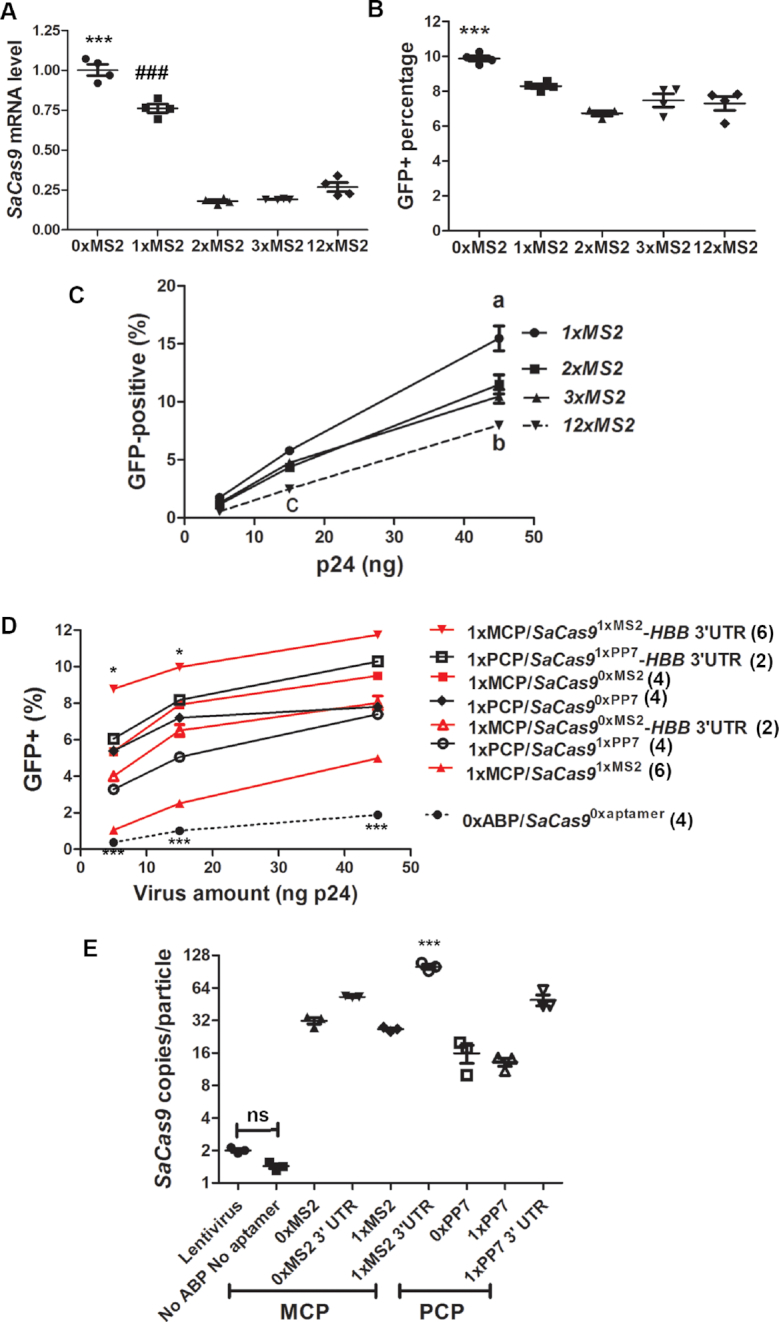
Gene editing activities of various LVLPs. (A) Effects of MS2 aptamers on SaCas9 mRNA level. Plasmid DNA expressing SaCas9nxMS2 (250 ng) was co-transfected into GFP-reporter cells grown in 24-well plates with plasmid DNA expressing HBB sgRNA1 (250 ng). SaCas9 mRNA level was compared by RT-qPCR with HBB sgRNA1 as a control. *** and ### indicate P < 0.001 when SaCas90xMS2 was compared with SaCas91xMS2, and when SaCas91xMS2 was compared with SaCas9 with more than one MS2 aptamer. (B) Effects of MS2 aptamers on SaCas9 gene editing activity. GFP-reporter cells were transfected as in A. Flow cytometry was performed 72 h after transfection. *** indicates P < 0.001 when SaCas90xMS2 was compared with SaCas9 with at least one MS2 aptamer. (C) Examining the effects of aptamer numbers on LVLP gene editing activity. LVLP-containing supernatants (titer determined by p24 ELISA) were co-transduced with 50 ng HBB sgRNA1-expressing IDLV into 2.5 × 104 GFP-reporter cells. Flow cytometry was performed 72 h after transduction. ‘a’ indicates that 45 ng p24 of SaCas91xMS2 LVLPs obtained significantly higher GFP-positive rate (P < 0.001) than all other LVLPs at the same dosage; ‘b’ indicates that 45 ng p24 of SaCas912xMS2 LVLPs obtained significantly lower GFP-positive rate (P < 0.001) than SaCas92xMS2 or SaCas93xMS2LVLPs; ‘c’ indicates that 15 ng p24 of SaCas912xMS2 LVLPs obtained significantly lower GFP-positive rate (P < 0.05) than all other LVLPs at the same dosage. Each data point is the mean of three replicates. (D) Flow cytometry analysis of GFP-positive cells generated after transducing various SaCas9-containing LVLPs. Designated amounts of SaCas9-containing LVLPs were co-transduced with 60 ng p24 HBB sgRNA1-expressing IDLV into 2.5 × 104 GFP-reporter cells. Each point was the average of indicated replicates (numbers in parentheses). * indicates P < 0.05 when SaCas91xMS2-HBB 3′ UTR LVLP was compared with any other particles of the same dosage; *** indicates P < 0.001 when LVLPs generated without ABP and aptamers were compared with any other particles of the same dosage. (E) RT-qPCR comparisons of SaCas9 mRNA copy numbers in different types of LVLPs. RNA was purified from lentivirus or LVLPs containing 30 ng p24. 30 ng p24 of GFP-lentivirus was added in each sample for experimental control. Copy numbers were compared to normal lentiviral vectors known to contain two RNA genomes/LV particle. Shown are individual data points and mean ± SEM. ns, no significant difference; ***P < 0.001 compared with any other groups. For A, B and E, Tukey's multiple comparison tests were performed following ANOVA analysis. For C and D, Bonferroni posttests were performed following two-way ANOVA.